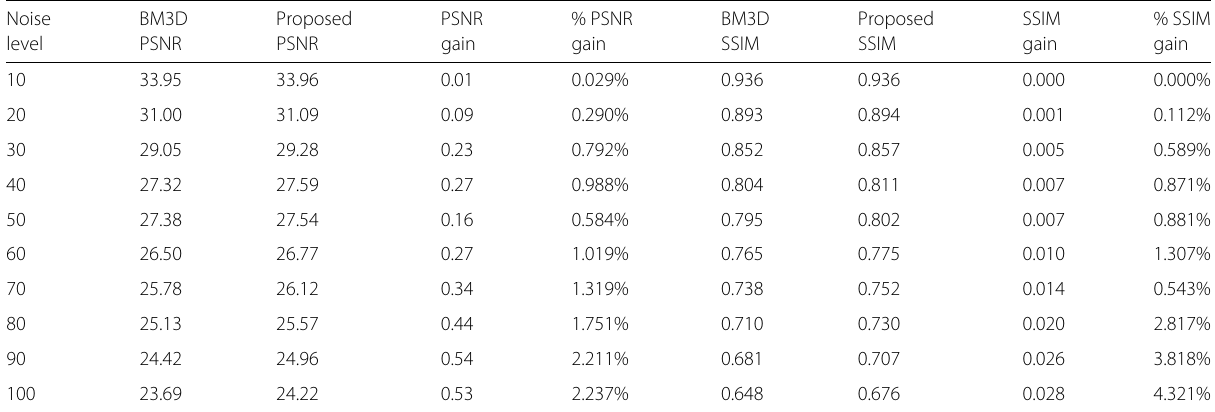
Table 5 Performance comparison of color profile (fast) and proposed method Noise